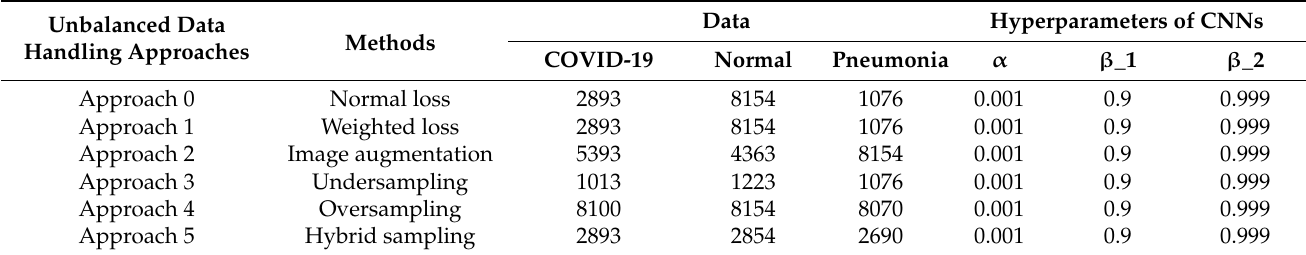
Table 2. The data associated with each approach for handling unbalanced class, and hyperparameters for fine-tuning CNNs. Unbalanced